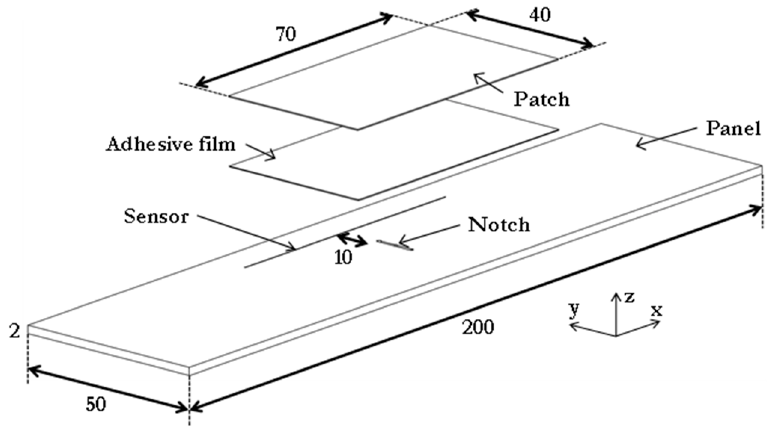
Figure 1. Schematic view of the repaired panel with the embedded chirped fibre Bragg grating (CFBG) sensor.